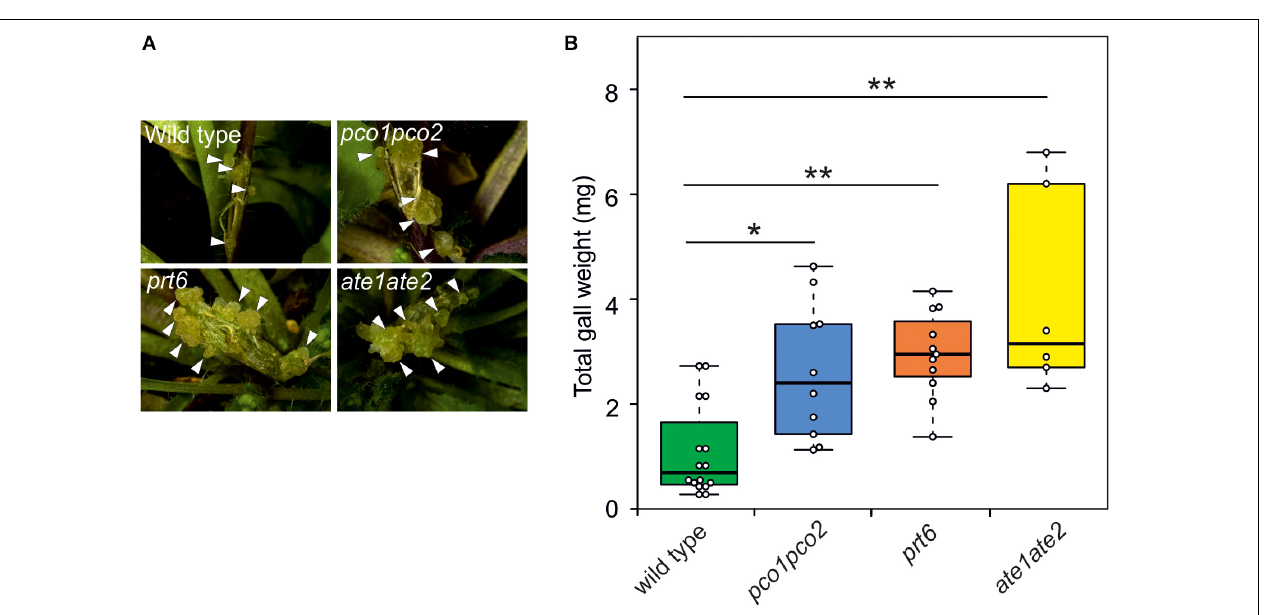
FIGURE 5 | Arabidopsis lines with a constitutively active hypoxia response show reduced crown gall symptoms. (A) representative images of crown gall disease symptoms at 21 dpi in wild type, pco1pco2 , prt6, and ate1ate2 plants. Scale bar, 1 mm. Crown galls are indicated with white arrows. (B) Gall fresh weight of wild type, pco1pco2 , prt6 and ate1ate2 plants at 21 dpi. Data are presented as boxplots. Stars indicate a statistically significant difference [ ∗ < 0.05, ∗∗ < 0.01, ANOVA followed by Holm-Sidak post hoc